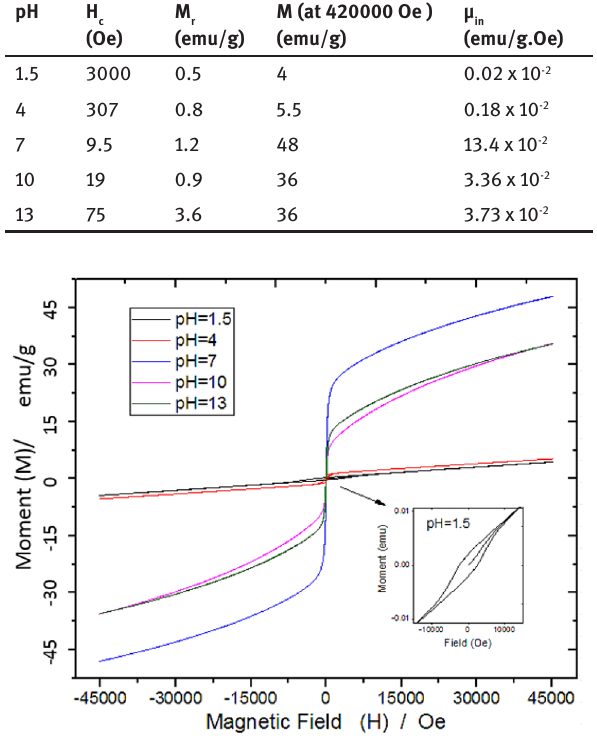
Figure 4: Hysteresis loops of samples prepared at pH=1.5, 4, 7, 10 and